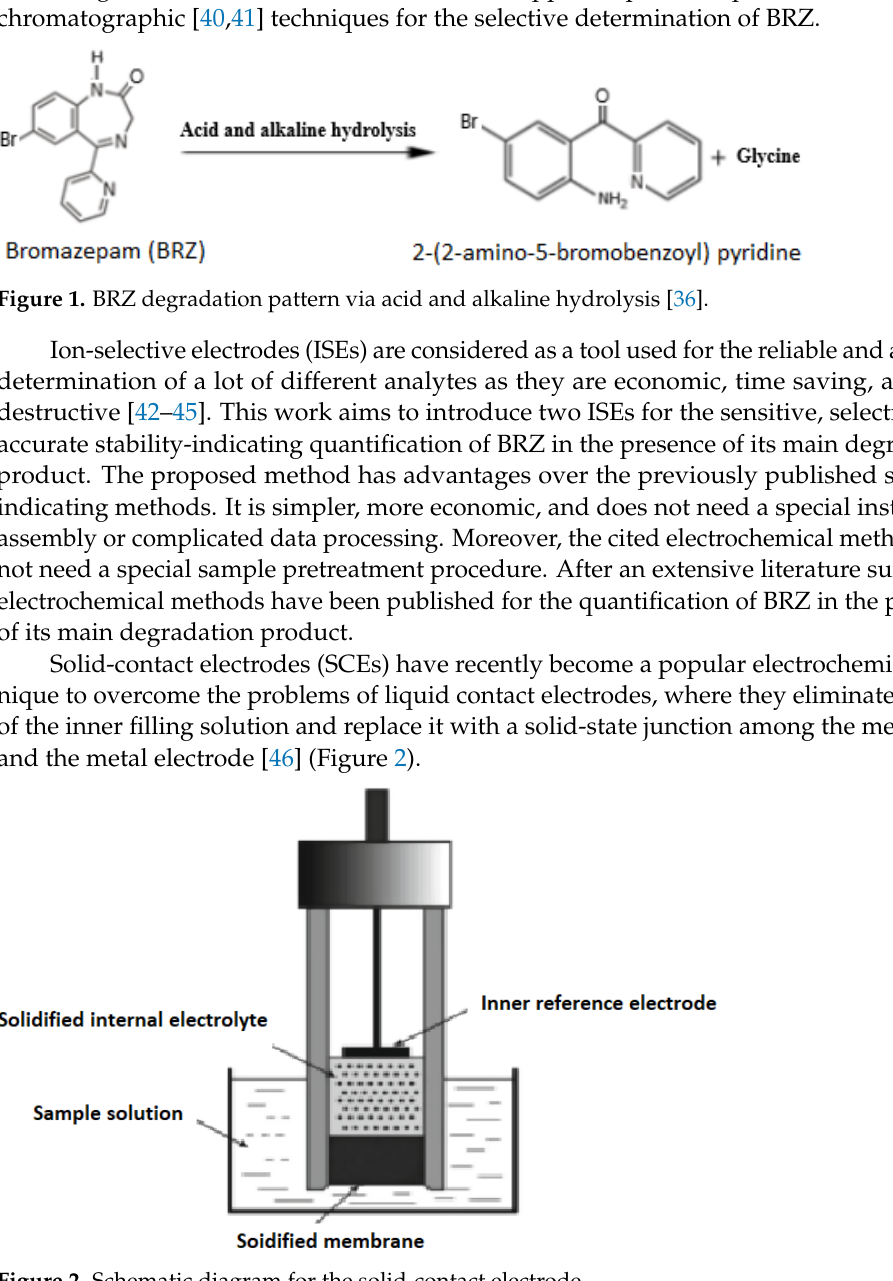
Figure 2. Schematic diagram for the solid-contact electrode.